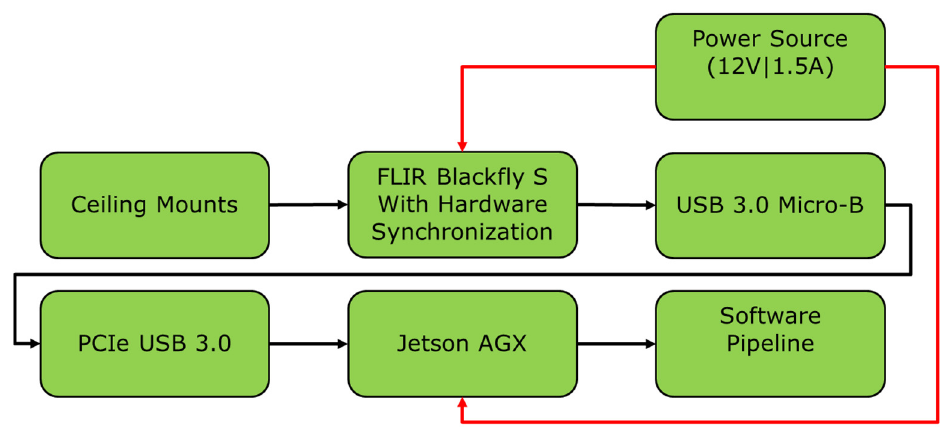
Figure 3. Hardware pipeline and connections for the Smart Figure 3 . Hardware pipeline and connections for the Smart Hallway.